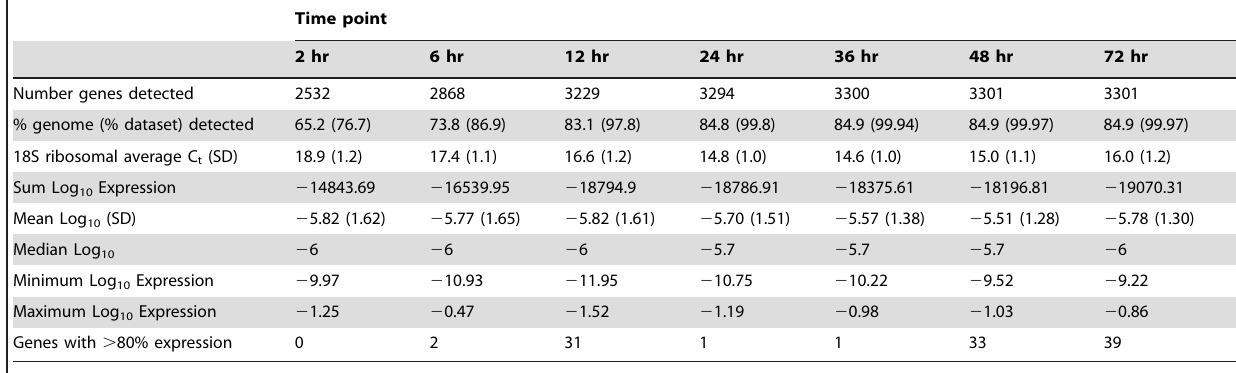
Table 1. Transcriptome Summary